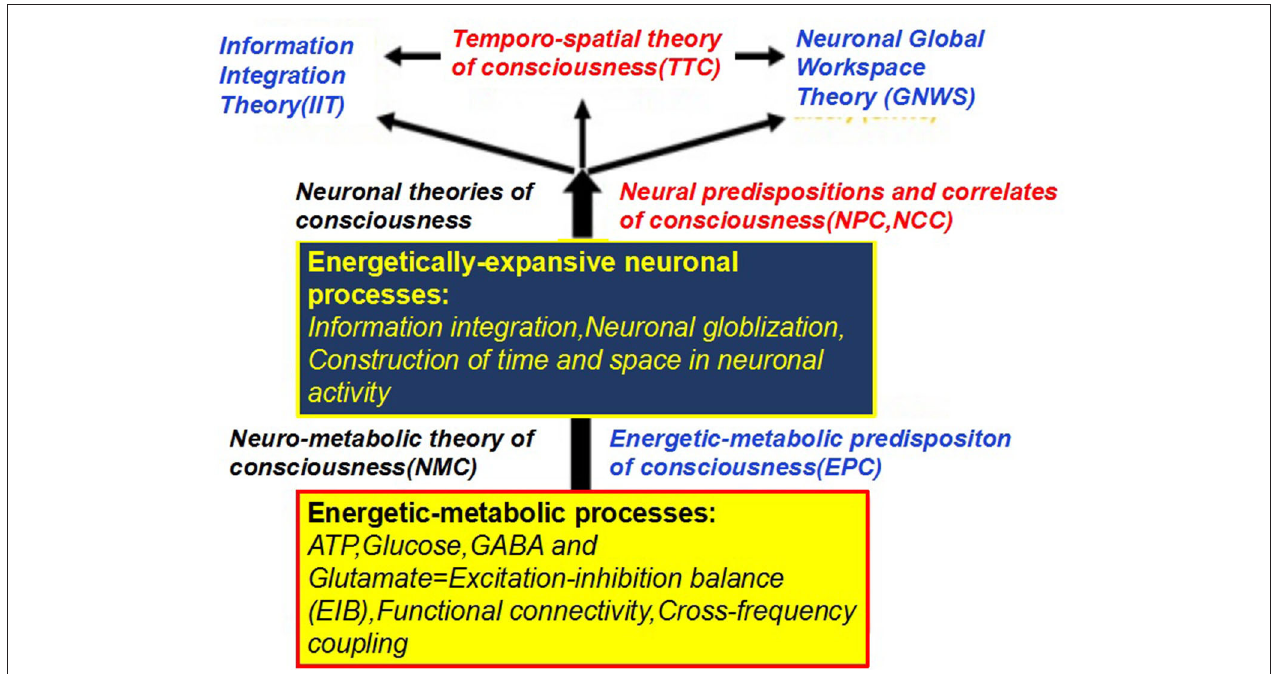
FIGURE 6 | Neuro-metabolic theory of consciousness and its relationship to neuronal theories of consciousness. The figure shows in the lower part the energetic-metabolic basis of those neuronal processes (middle part) that are cost expensive and require lots of energic metabolisms to yield consciousness as postulated in various neuronal theories of consciousness (upper